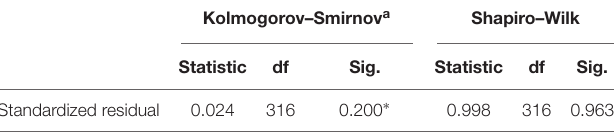
TABLE 7 | Tests of normality of Kolmogorov–Smirnov and